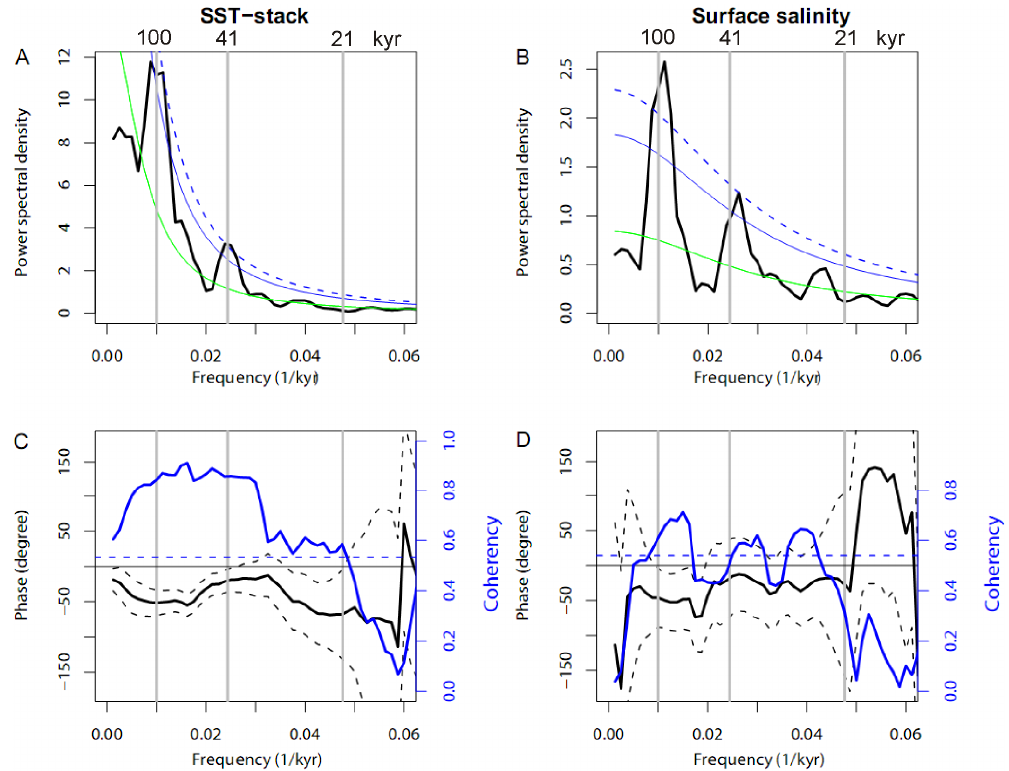
Fig. 5. Frequency spectra for Agulhas proxies (SST and SSS) and their coherence and phase relationships relative to global ice volume ( δ 18 O benthic ). (A) Power spectral density of SST (black). A red noise background spectrum (green) and 95% (blue continuous) and 99% (blue dashed) confidence levels, relative to the red-noise background are given. (B) The same as in (A) but for SSS. (C) coherence (blue) and phase (black) between the SST proxy and − 1 · δ 18 O benthic . The approximate 95% confidence level for the coherence (blue dashed line) and the 95% confidence interval for phase (black dashed line) are given. (D) The same as in (C) but for the SSS and − 1 · δ 18 O benthic relationship. A negative phase indicates that the Agulhas records are leading − 1 · δ 18 O benthic . The orbital frequencies 1/100 kyr, 1/41kyr and 1/21kyr are marked with vertical grey